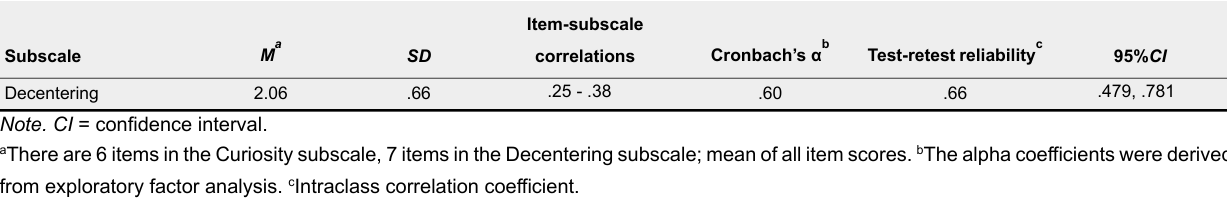
Correlations of the Chinese Translated Toronto Mindfulness Scale – Trait Version (C-TMS-T) with SWLS, TAI and the subscales of FFMQ TAISWLSC-TMS-T subscale NonreactNonjudgeActawareDescribeObserve